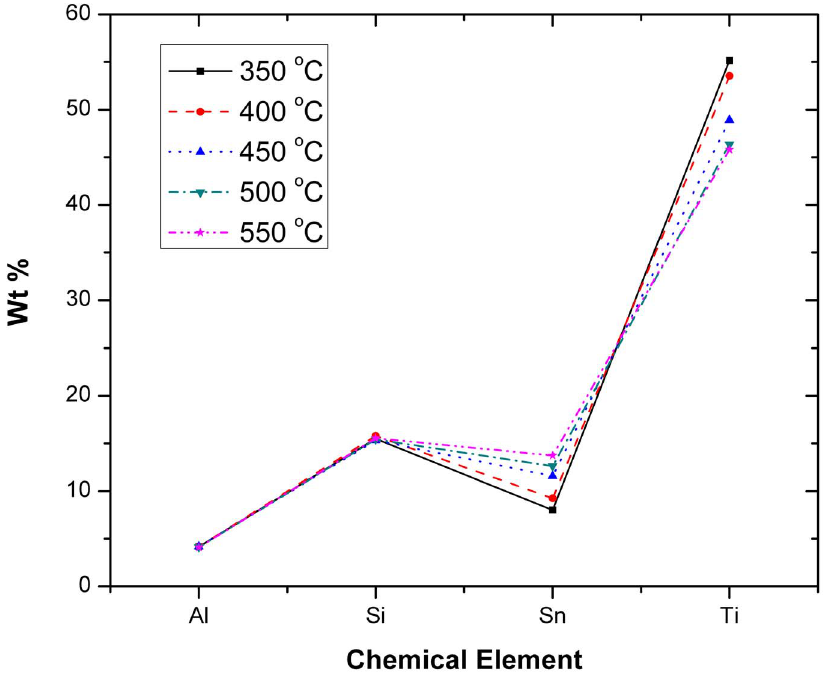
Figure 10. The EDX analysis (recorded for the areas in Figure 7 for each temperature) quantifying the Sn diffusion increase when increasing the sintering temperature from 350 6 C to 550 6 C.